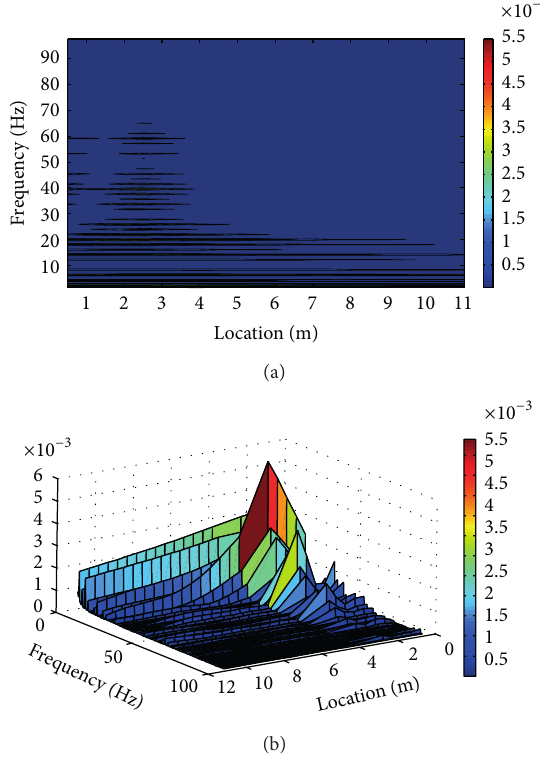
Figure 11: Location-frequency figure with an open trench of 𝐿 = 10m, 𝑊 = 1m, and 𝐻 = 3m (a) contour plot of displacement spectrum on ground surface and (b) surface plot of displacement spectrum on ground surface (Poisson’s ratio ] = 0.25, train speed 𝑉 = 180km/h). Note: the location coordinate of trench is from 2.5 to 3.5 m.